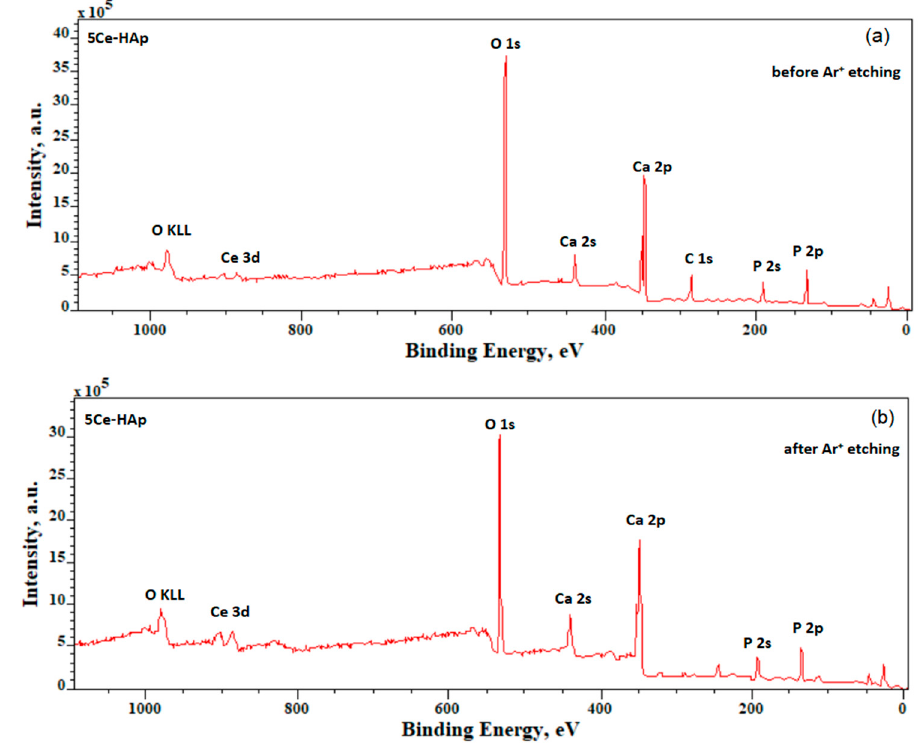
Figure 5. Spectra of the 5Ce-HAp coating before ( a ) and after ( b ) etching.